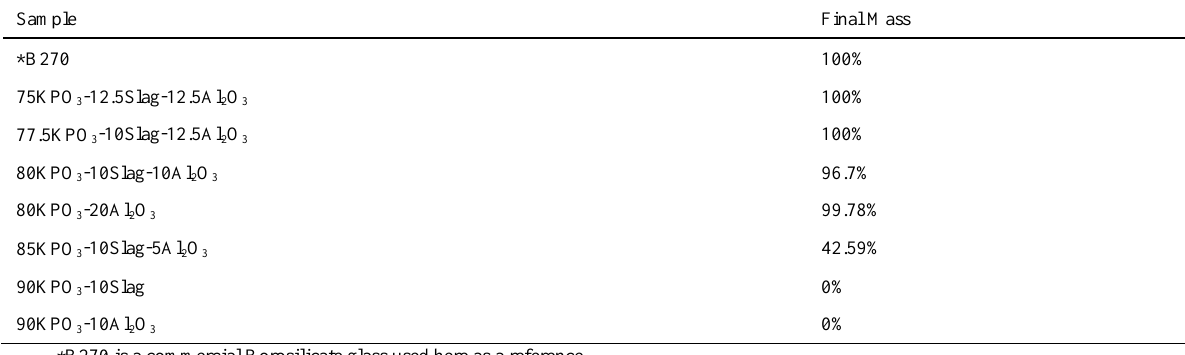
Table 2: Samples of series 1 that remained 24h under demineralized